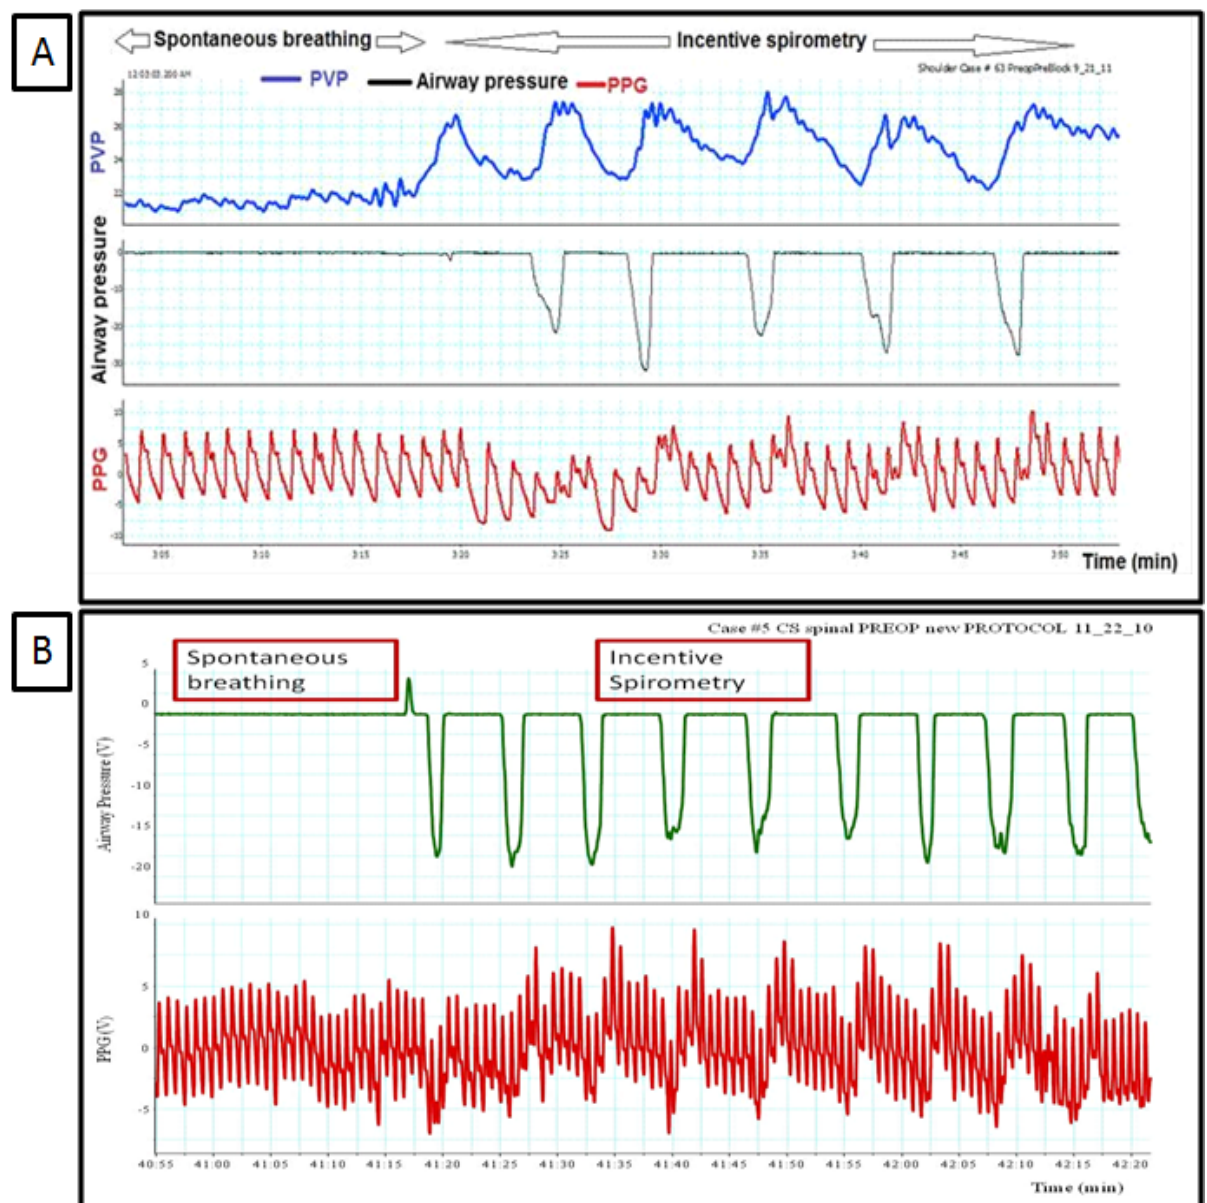
Figure 2. ( A ) and ( B ) show the impact of calm spontaneous breathing and incentive spirometry (deep rapid breathes) on peripheral venous pressure (PVP) and PPG waveforms, notice that incentive spirometry breathing is an exaggerated response of the spontaneous breathing